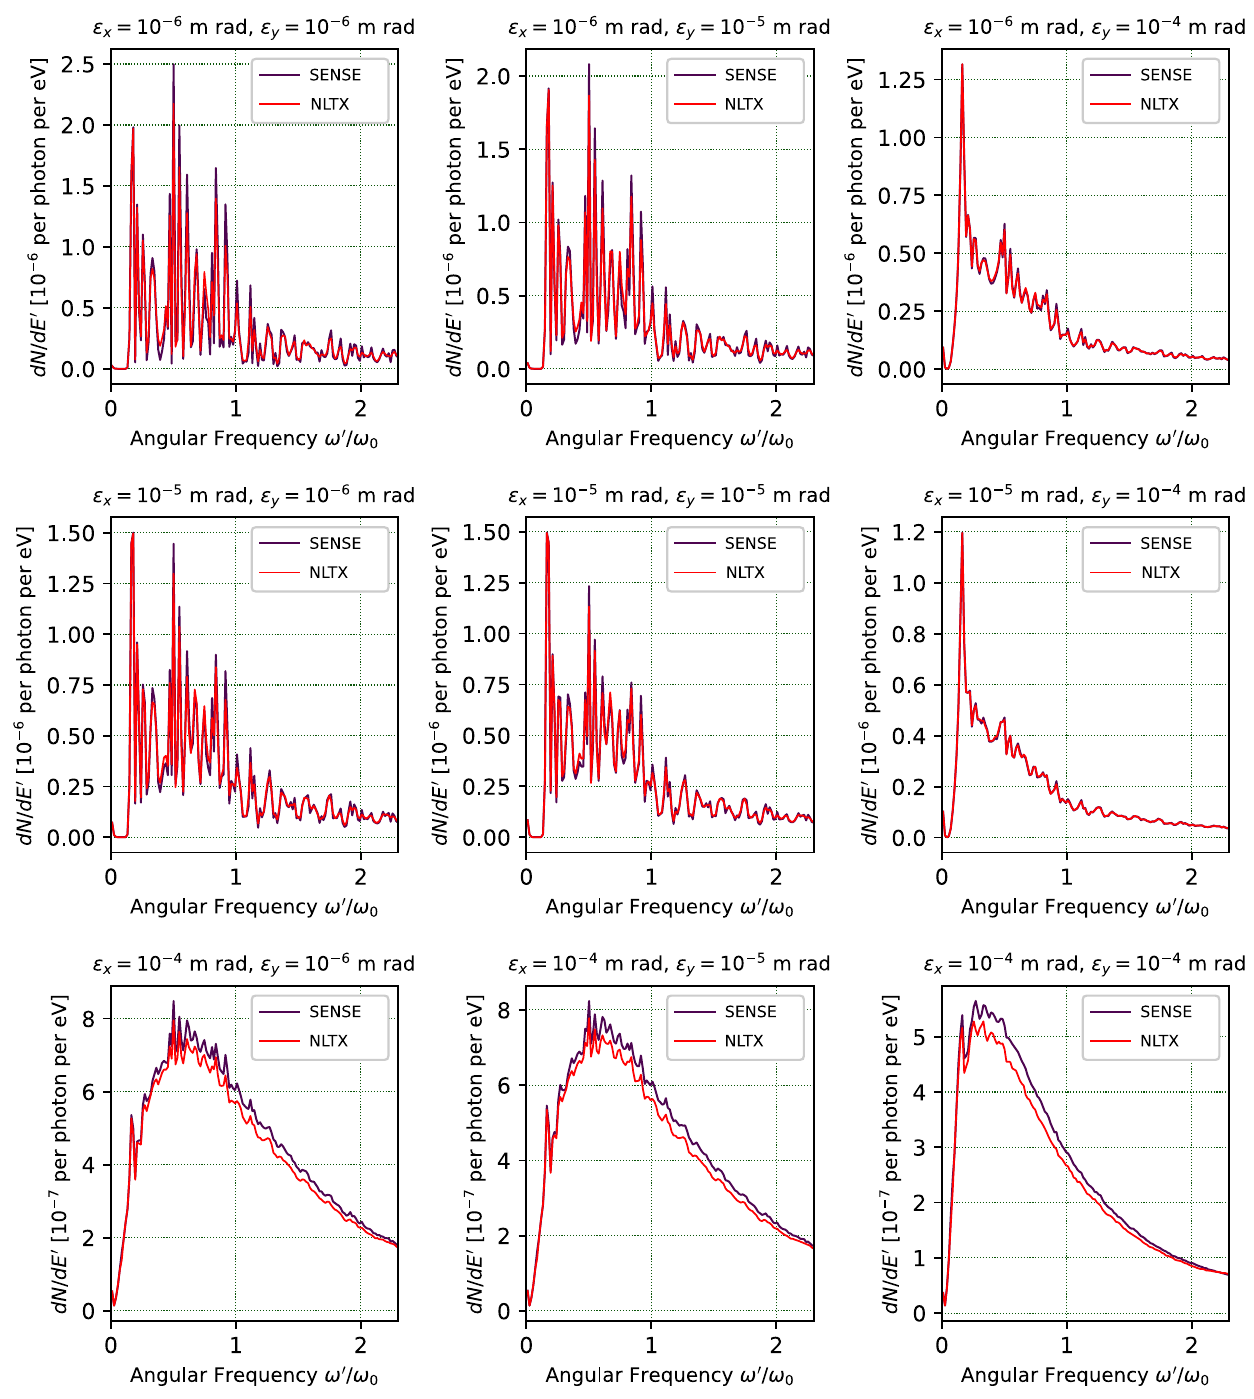
FIG. 5. Simulated spectra from SENSE and NLTX for field strength a 0 ¼ 3 . 25 and a range of normalized horizontal emittance ϵ x and normalized vertical emittance ϵ y values. The following parameters were used in the simulations: E e ¼ 23 MeV; Δ E e =E e ¼ 0 . 175% ; σ ¼ 41 μ m; σ ¼ 81 μ m; λ ¼ 800 nm; σ ¼ 13 . 59 μ m; σ ¼ 13 . 59 μ m; σ ¼ 5 . 57 . The scattered frequency is scaled by the x y x;l y;l normalizing frequency ω 0 ¼ 2 π c= λ